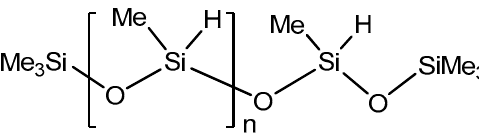
Scheme 1. General structure of PMHS (polymethylhydrosiloxane).